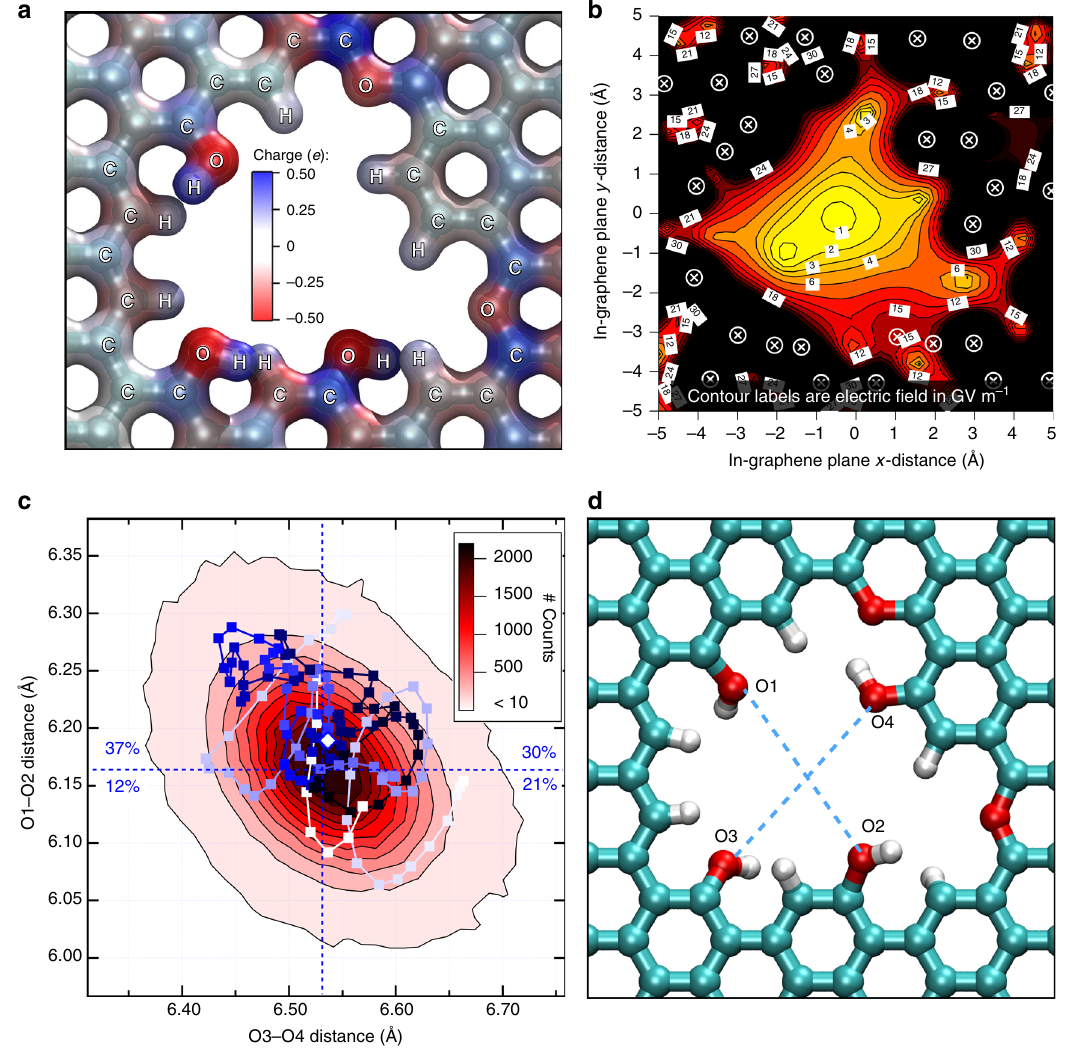
Fig. 3 Large electrostatic fi eld and breathing of two nanowindows. a Partial charges in NW-3.78 nanowindow calculated according to MK scheme. b Contour plot for in-graphene plane magnitude of the electric fi eld in GV m − 1 calculated from partial charges shown in a for NW-3.78. Circles with crosses indicate position of atoms. c 2D histogram contour of the distances between two pairs of O atoms on opposite sides of the rim during an MD simulation in NW-3.30. Vibration is asymmetric with a Pearson correlation coef fi cient between O1 – O2 and O3 – O4 of − 0.38. The blue-gradient path corresponds to the distances when a N 2 molecule permeated through the nanowindow. Darker marks correspond to N 2 -center of mass closer to the nanowindow center in the z -direction. d Atomic numbering used to calculate lengths in c . Cyan, red and white atoms are C, O, and H,